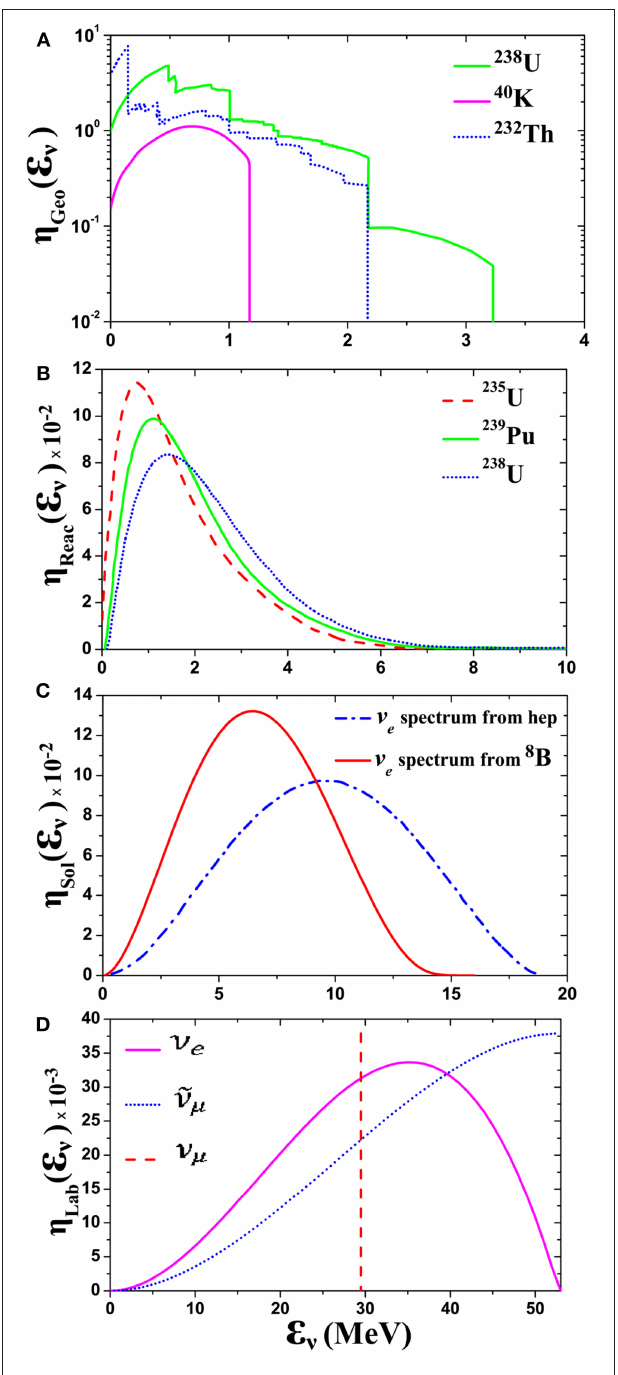
FIGURE 3 | (A) Spectra of the U-Series, Th-Series, and 40 K Geo-Neutrinos. Neutrinos from 40 K electron capture are also shown in this figure. (B) Normalized reactor neutrino spectra. (C) Normalized energy spectrum of 8 B and hep ν e solar neutrinos. (D) Energy-spectra of ν e and generated from the muon-decay at rest (see e.g., [ 71,